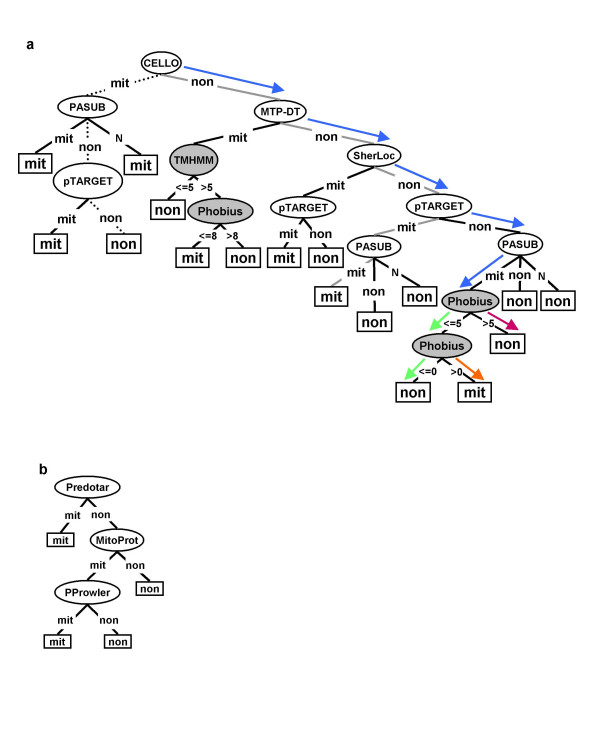
Decision tree topology for the prediction of mitochondrial proteins. a, STACK-mem-DT; b, MTP-DT. The trees were built by C4.5 (see Methods). Each oval represents a prediction tool. Filled ovals represent transmembrane domain predictors. Rectangle represents a decision: "mit" for mitochondrial proteins and "non" for proteins of other subcellular locations. If a tool predicts the query protein as a mitochondrial protein, the branch (edge) is labeled "mit"; otherwise "non". If PASUB makes no prediction, the branch is labeled "N". Several decision-making paths are highlighted, as follows: Dotted line: for non-mitochondrial protein YDR378C. Grey line: for mitochondrial protein YOR297C. Blue arrow: the common path for three differently localized proteins: mitochondrial (YIL065C), plasma membrane (YBR069C) and nuclear (YLL022C). Orange arrow: for mitochondrial protein YIL065C. Red arrow: for non-mitochondrial protein YBR069C. Green arrow: for non-mitochondrial protein YLL022C.